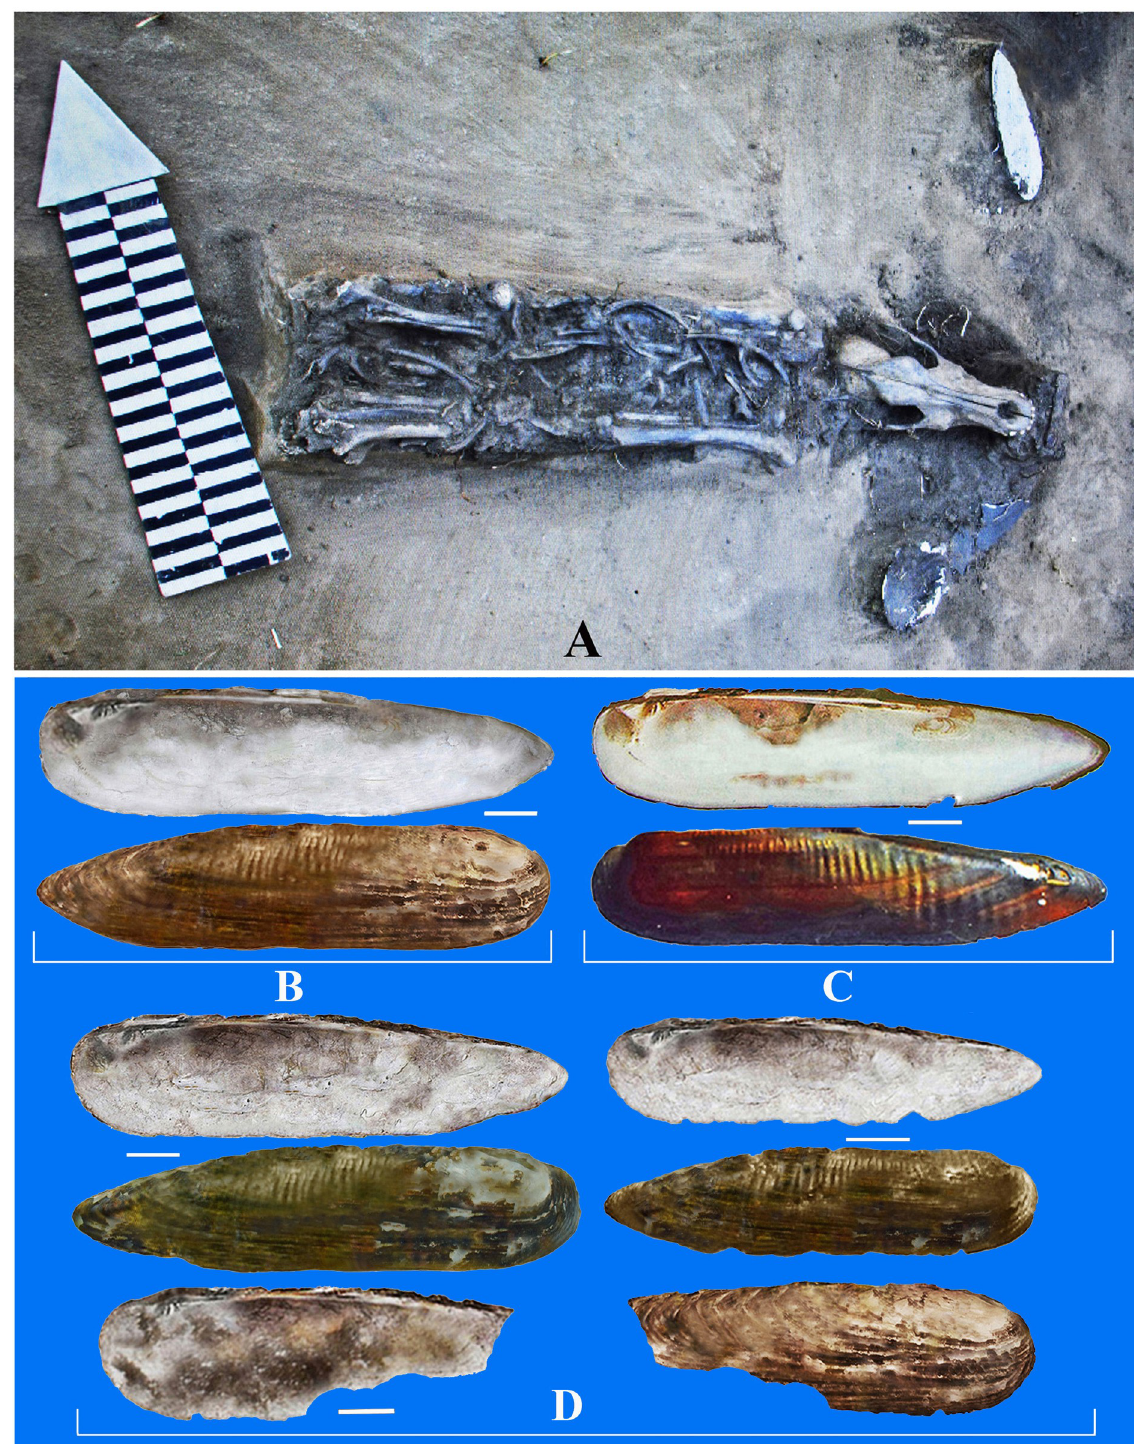
Fig 4. A ritual dog burial in the dugout 28 in the fortress Proezzhaya I. A –the dog skeleton, the left of his skull is a shell valve of Lanceolaria grayii , to the right of the dog skull–valve fragment of Margaritifera dahurica . B – L . grayii from the dog burial, C –recent L . grayii from Khanka Lake. D–shell valves of L . grayii from the bank of defensive fortifying excavation deposits. Scale bar 1 cm.